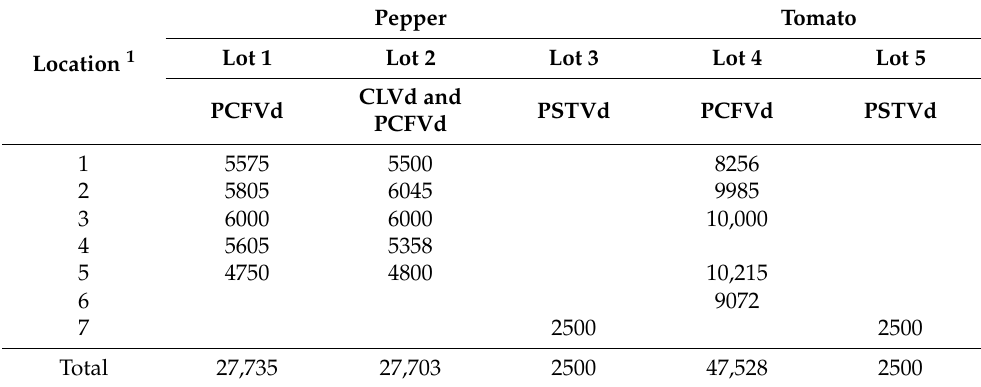
Table 2. The number of pepper and tomato plants raised from infested seed lots and distributed over the different